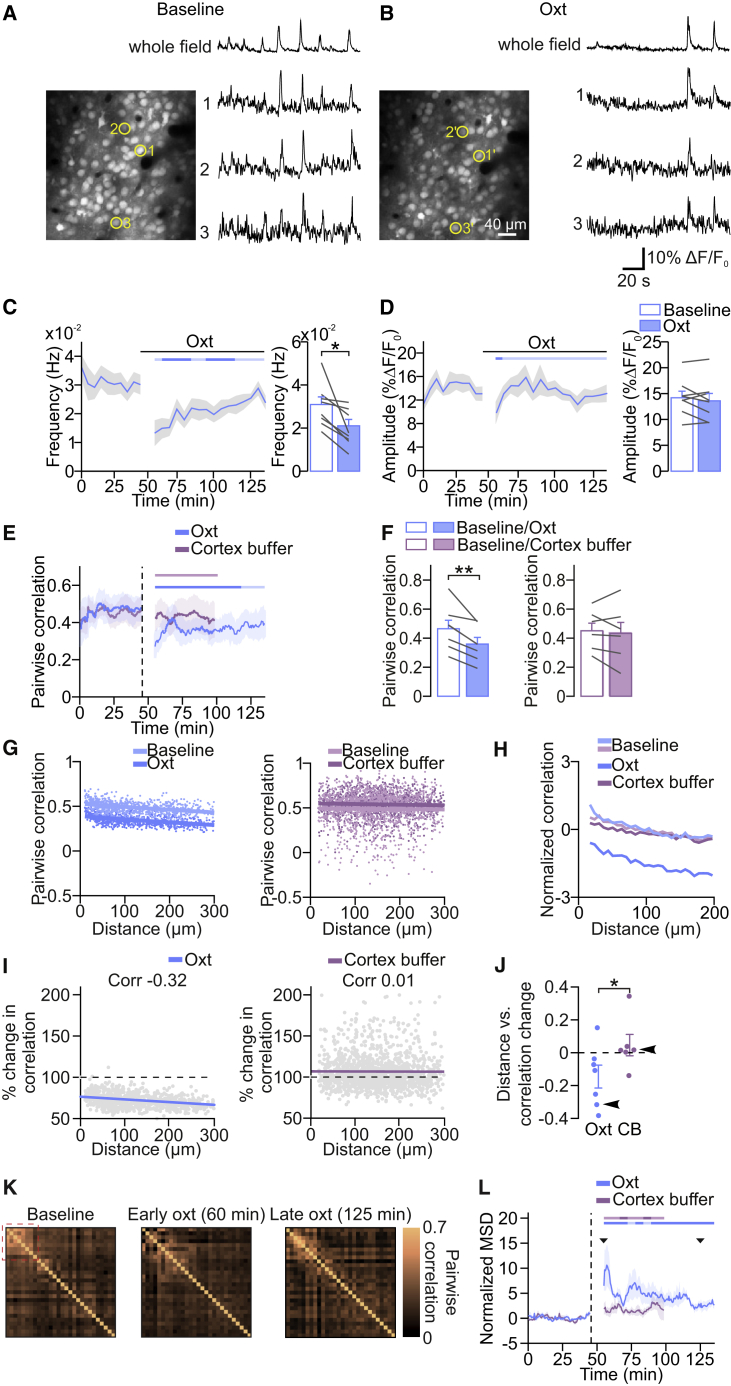
Oxytocin Desynchronizes Network Activity in V1(A and B) V1 network activity before and after oxytocin application. (Left) Layer 2/3 neurons labeled with the calcium indicator Oregon Green-BAPTA 1 are shown. Traces show fluorescent changes of three example neurons and the average activity across all cells.(C) Network event frequency during baseline and after oxytocin application. Imaging resumed approximately 10 min after oxytocin application. The frequency of network events was reduced after oxytocin application. The horizontal bar indicates significant deviations from baseline as in Figure 1 (dark shades; paired two-tailed t test; p < 0.05; without multi-measurement correction). ∗p = 0.015 (n = 8 animals; paired two-tailed t test).(D) Network event amplitude during baseline and after oxytocin application.(E) Time course of pairwise Pearson correlation coefficients before and after oxytocin and cortex buffer application. Dashed vertical line indicates the time point of oxytocin or cortex buffer application. Time course represents averages of sliding 7-min window (for details see STAR Methods). The horizontal bar indicates significant deviations from baseline as in Figure 1 (dark shades; paired two-tailed t test; p < 0.05; without multi-measurement correction).(F) Mean correlations after oxytocin or cortex buffer control applications. ∗∗p = 0.003 (n = 7 for oxytocin; n = 6 for cortex buffer; paired two-tailed t test).(G) Pairwise correlations plotted against interneuronal distance for an example of oxytocin (left) and cortex buffer (right) conditions.(H) Mean pairwise correlations in oxytocin and cortex buffer condition. Note that baseline condition and cortex buffer display the same profile.(I) Change in pairwise correlations plotted against interneuronal distance for an example of oxytocin (left) and cortex buffer (right) conditions. Dashed lines indicate zero change in correlations. Colored lines indicate linear fits (left, p < 10−10; right, p = 0.47; paired two-tailed t test).(J) Pearson correlation coefficients between pairwise distances and percentages of change in correlations for all animals in oxytocin and cortex buffer condition. Arrowheads indicate the examples shown in (I). ∗p = 0.037 (n = 7 for oxytocin; n = 6 for cortex buffer; unpaired two-tailed t test).(K) Correlation matrices computed baseline, early oxytocin (60 min), and late oxytocin (125 min). Red dotted square indicates an example of a subgroup of neurons that undergo structural changes.(L) Normalized mean squared distances (MSDs) between the baseline matrix and the correlation matrices computed from a sliding 7-min window (see STAR Methods for details) as function of time for oxytocin and cortex buffer conditions.Data are represented as mean ± SEM. See also Figure S1.